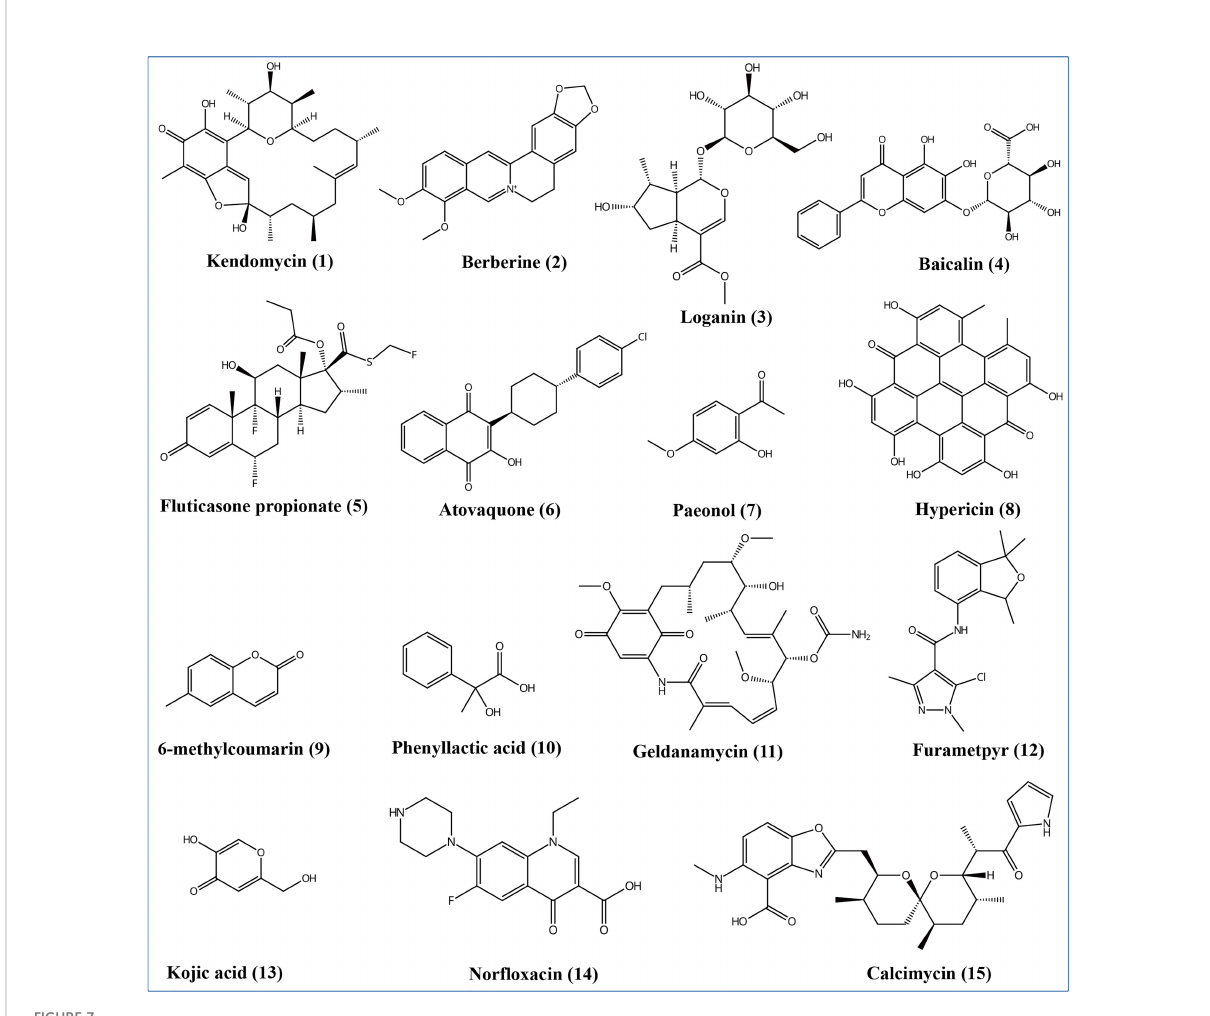
FIGURE 7 Some different structural types of antimicrobial secondary metabolites from Epicoccum latusicollum